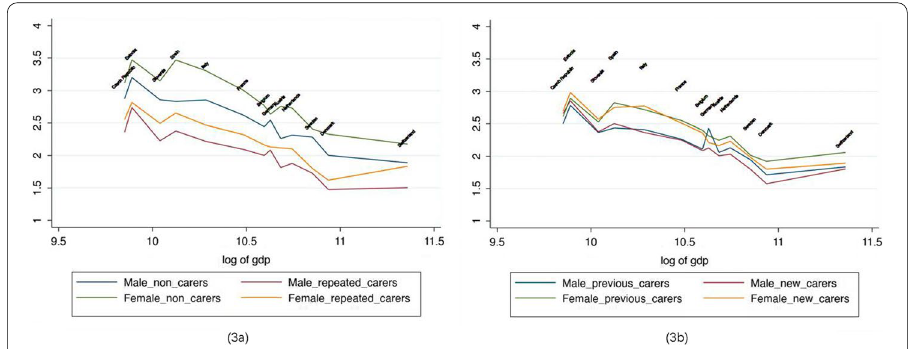
Fig. 3 Predicted depressive symptoms on grandchild caring patterns for grandfathers and grandmothers by a country’s GDP. Note: The depressive symptoms were predicted based on Model 5 ( Source: Authors’ analysis of the Harmonised SHARE Waves